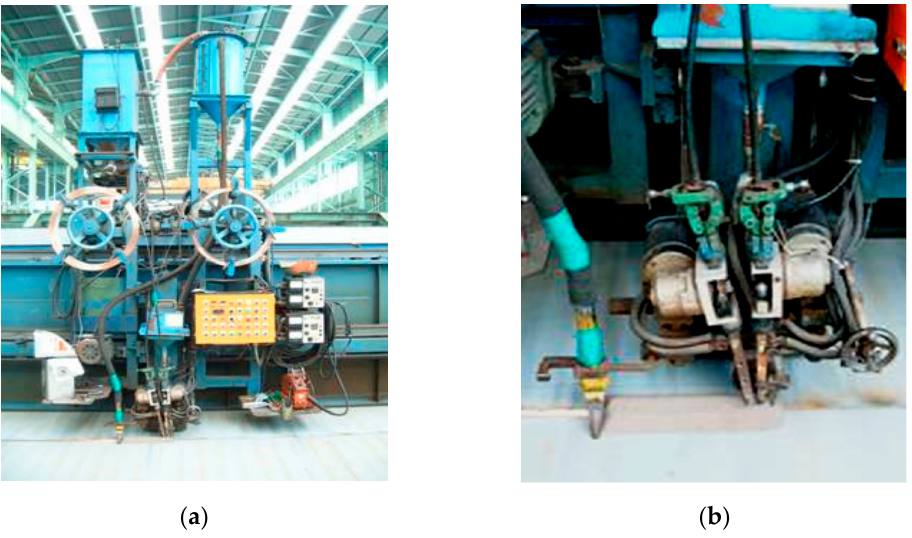
Figure 3. Tandem SAW equipment at the panel stage: ( a ) tandem SAW equipment; ( b ) head of tandem SAW equipment.